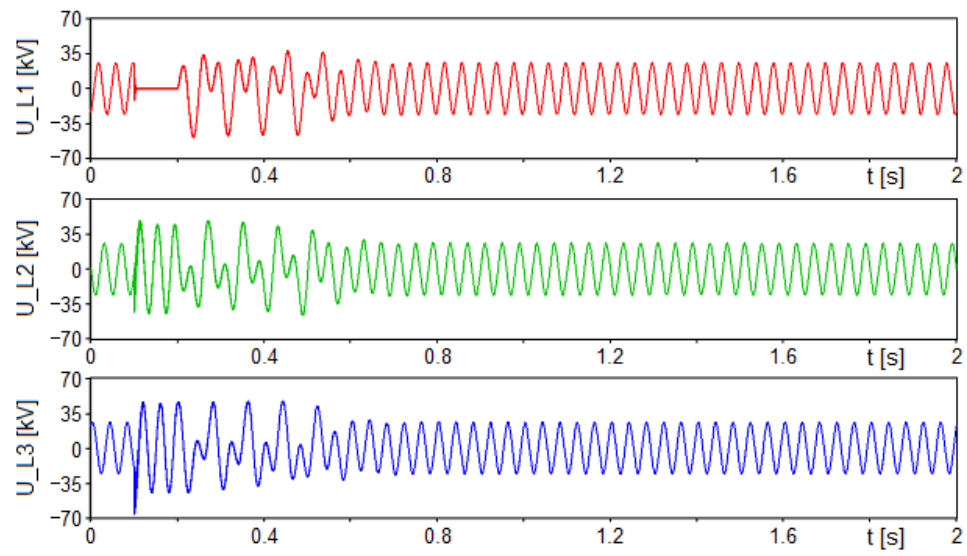
Figure 12. Waveforms of phase voltages on the primary side of voltage transformers, including the attenuation resistor R_OTD = 10 Ω in the additional winding system.